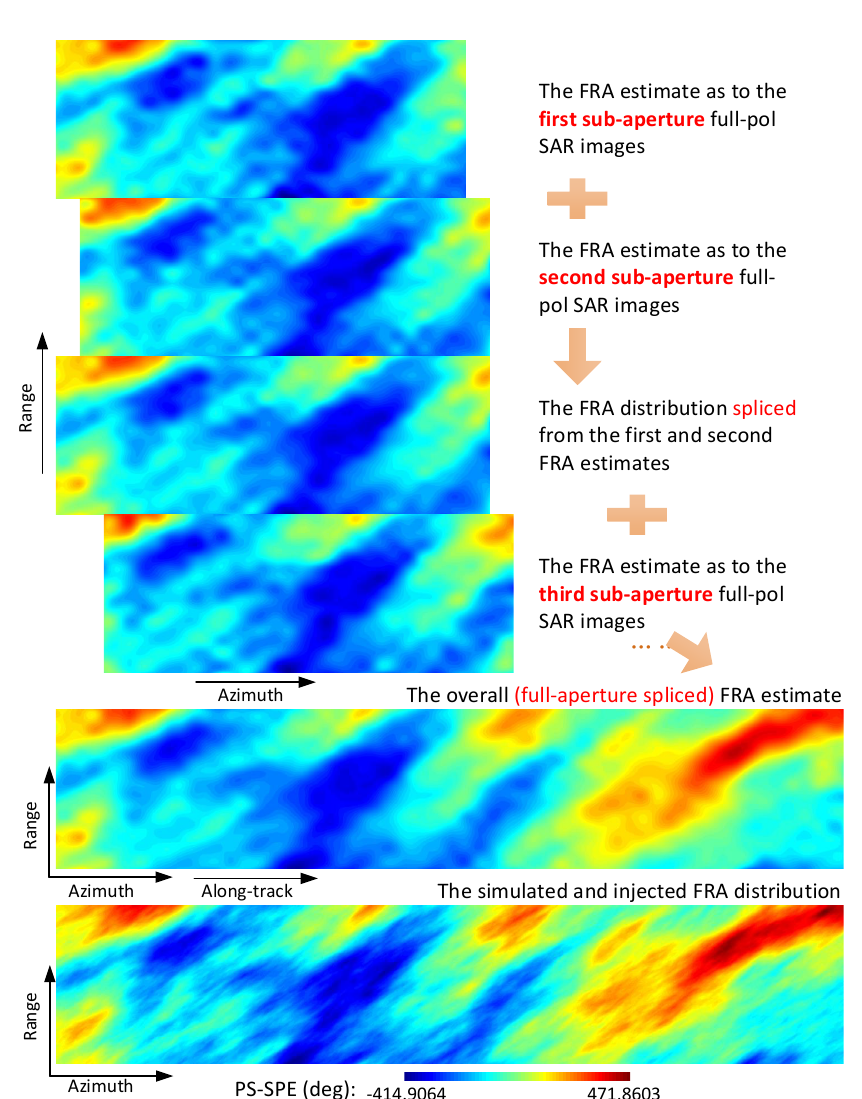
Figure 9. The schematic diagram of the integral processing scheme for the overall SPE estimation.